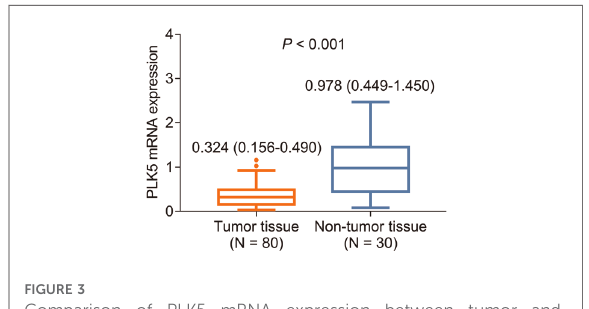
FIGURE 3 Comparison of PLK5 mRNA expression between tumor and nontumor tissues in NSCLC patients.